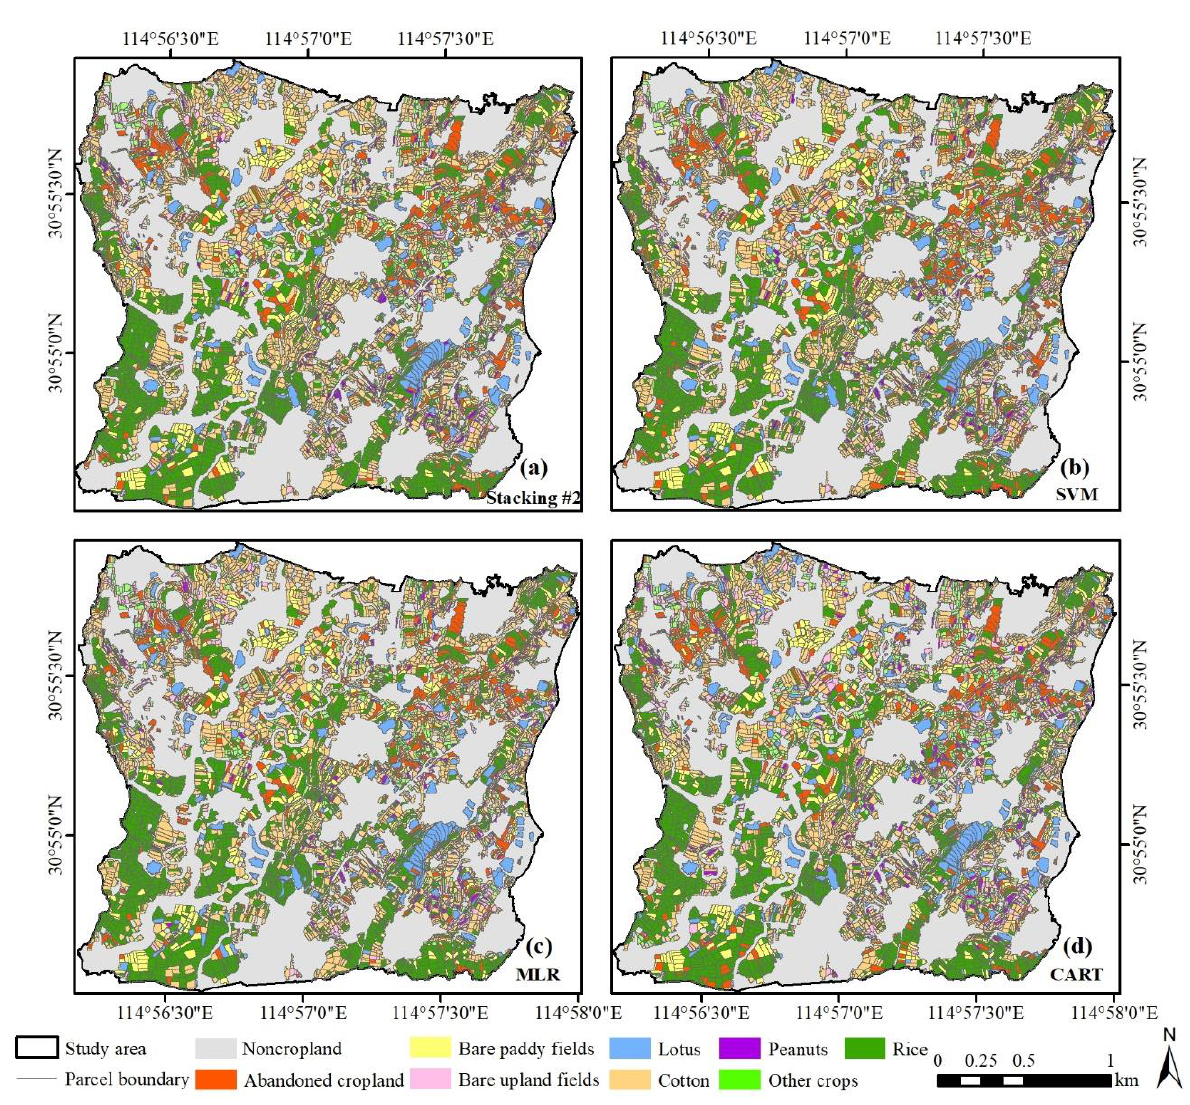
Figure 6. Crop type distribution predicted by the Stacking #2 ( a ), SVM ( b ), MLR ( c ) and CART ( d ) classifiers.